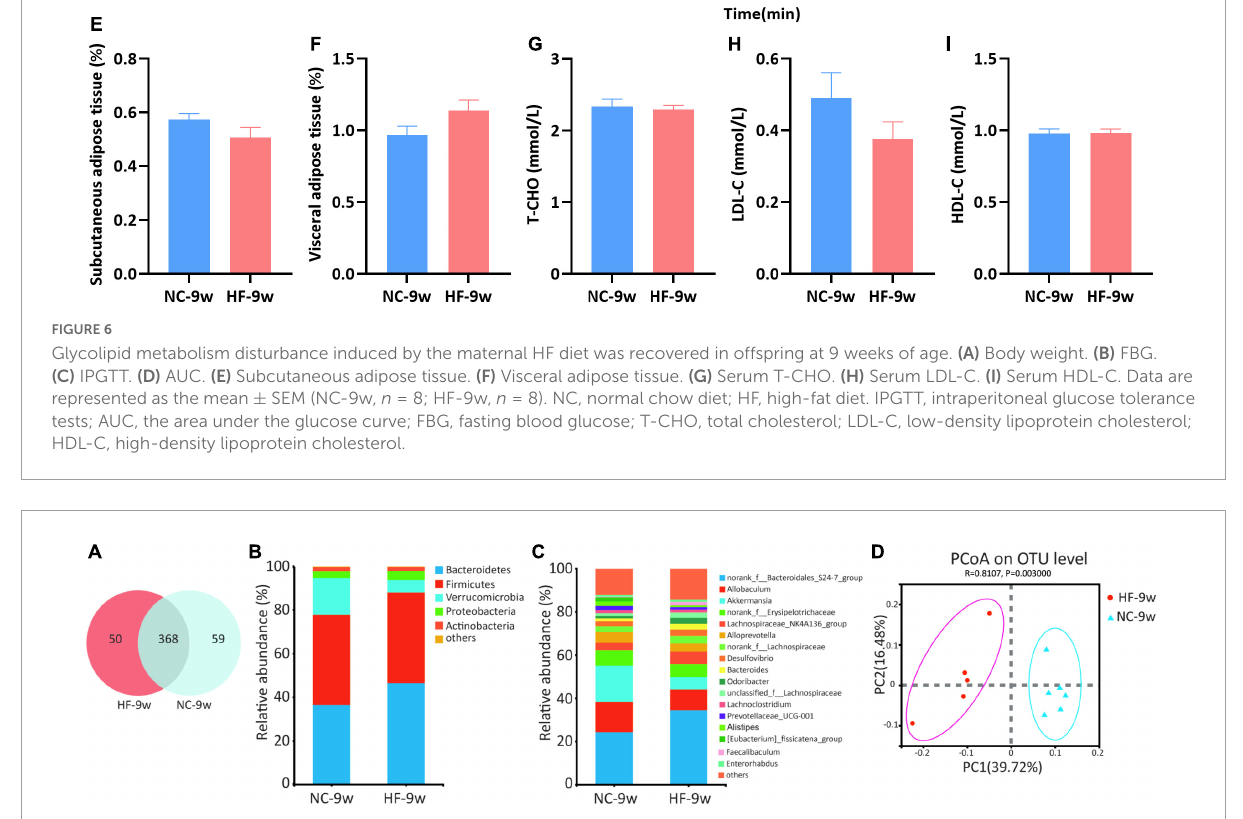
FIGURE7 Dysbiosis of gut microbiota was partly restored by a normal diet in offspring at 9 weeks of age. (A) Venn diagram of the OUTs. (B) Relative abundance of the bacterial population at the phylum level. (C) Relative abundance of the bacterial population at the genus level. (D) PCoA plots of gut communities (NC-9w, n = 6; HF-9w, n = 5). NC, normal chow diet; HF, high-fat diet. OTUs, operational taxonomic units; PCoA, principal coordinate